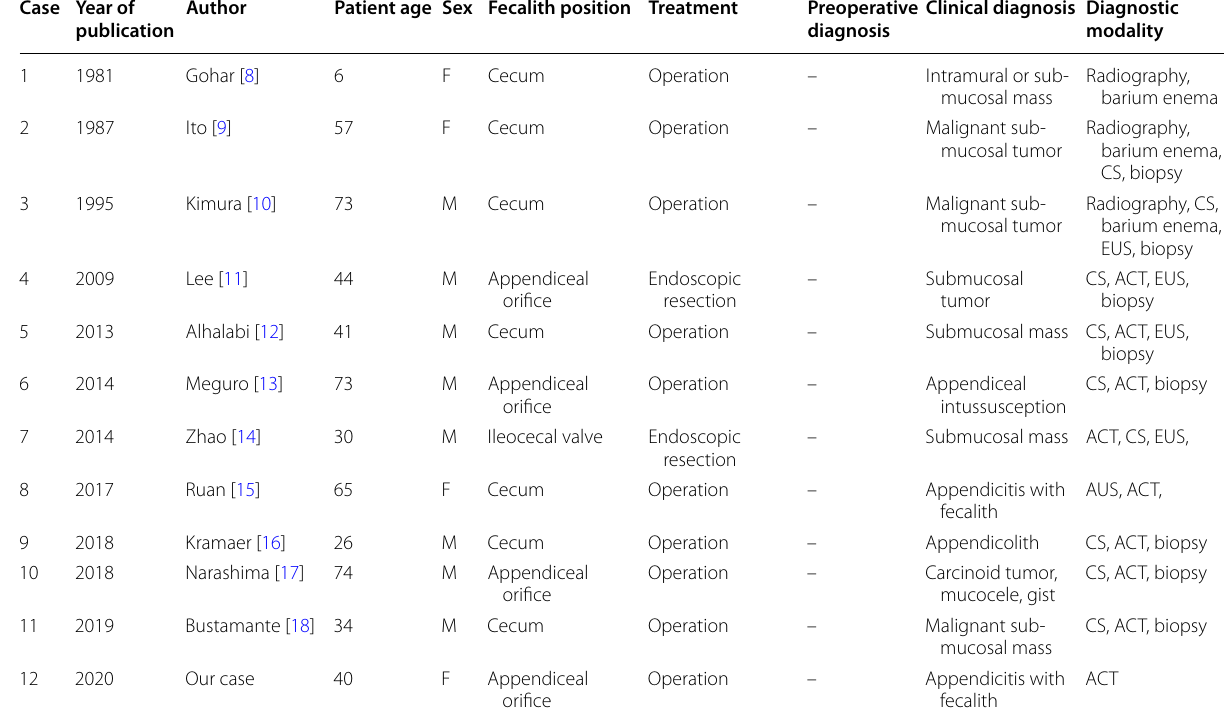
Table 1 Review of diagnosed cases of submucosal